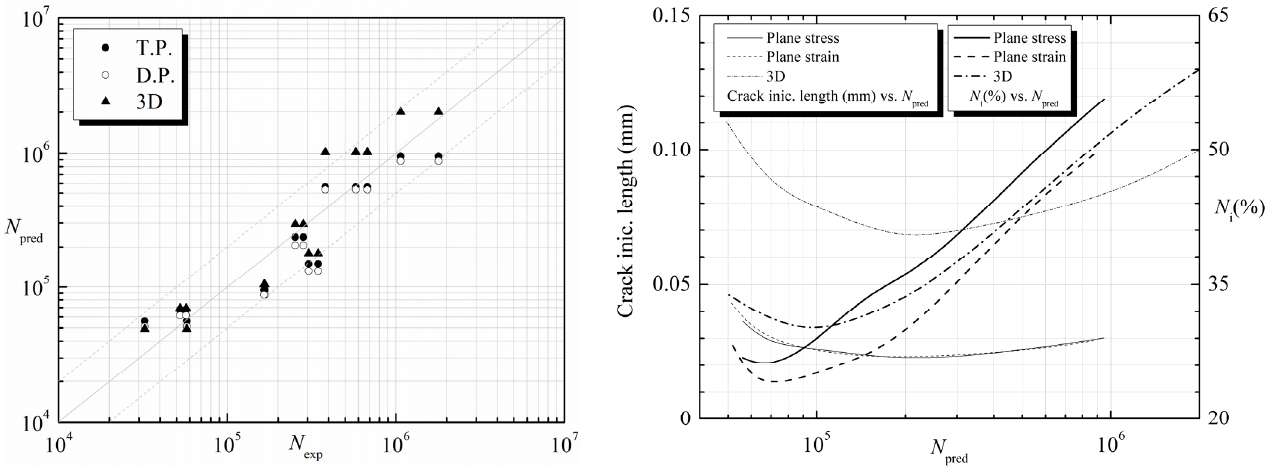
Figure 8: N pred vs. N exp . Figure 9: Crack initiation length vs. N pred and N i (%) vs. N pred